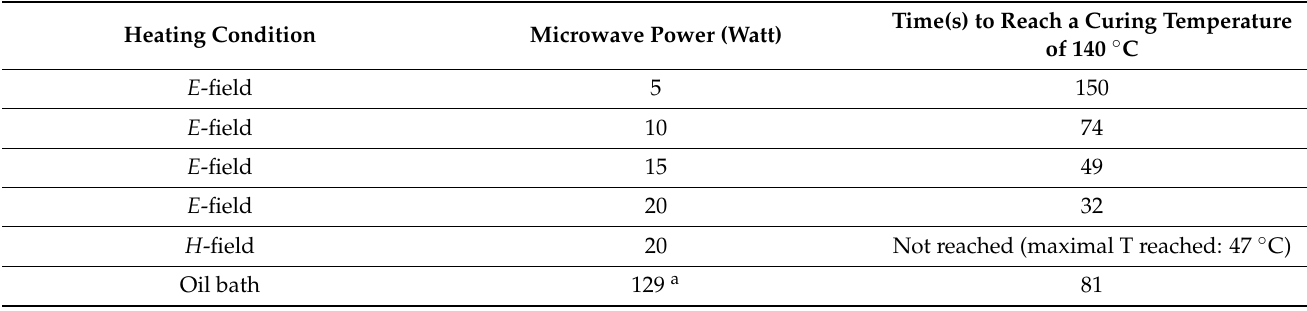
Table 1. Microwave power and curing times for the (BADGE + PA + EM) adhesive using the microwaves’ electric field heating ( E -field), the microwaves’ magnetic field heating ( H -field), and oil-bath heating to reach a temperature of 140 ◦ C. Heating